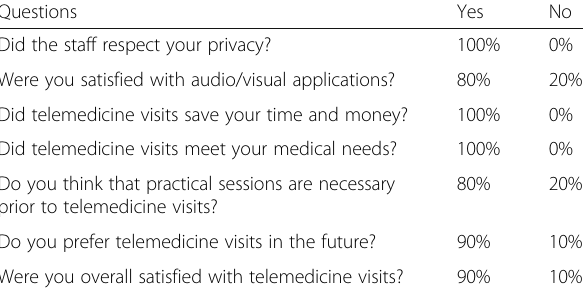
Table 1 Patient satisfaction questionnaire